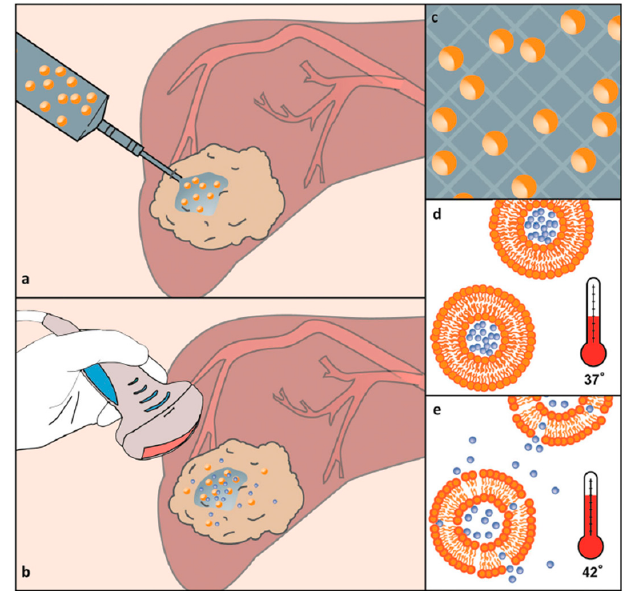
containing a suspension of DOX-loaded thermosensitive liposomes. ( b ) Release from the gel in situ is controlled using minimally invasive hyperthermia, which is achievable using high intensity-focused ultrasound. A small portion of the drug-loaded liposomes is released from the Lipogel, maximizing the drug delivery distance from the gel implant. ( c ) The majority of liposomes are locked into the gel upon initiation of cross-linking during thermogelation. ( d , e ) Liposomes sequester the majority of the drug at body temperature but rapidly become more permeable upon mild hyperthermia and release their drug payload. Reprinted with permission from Ref.